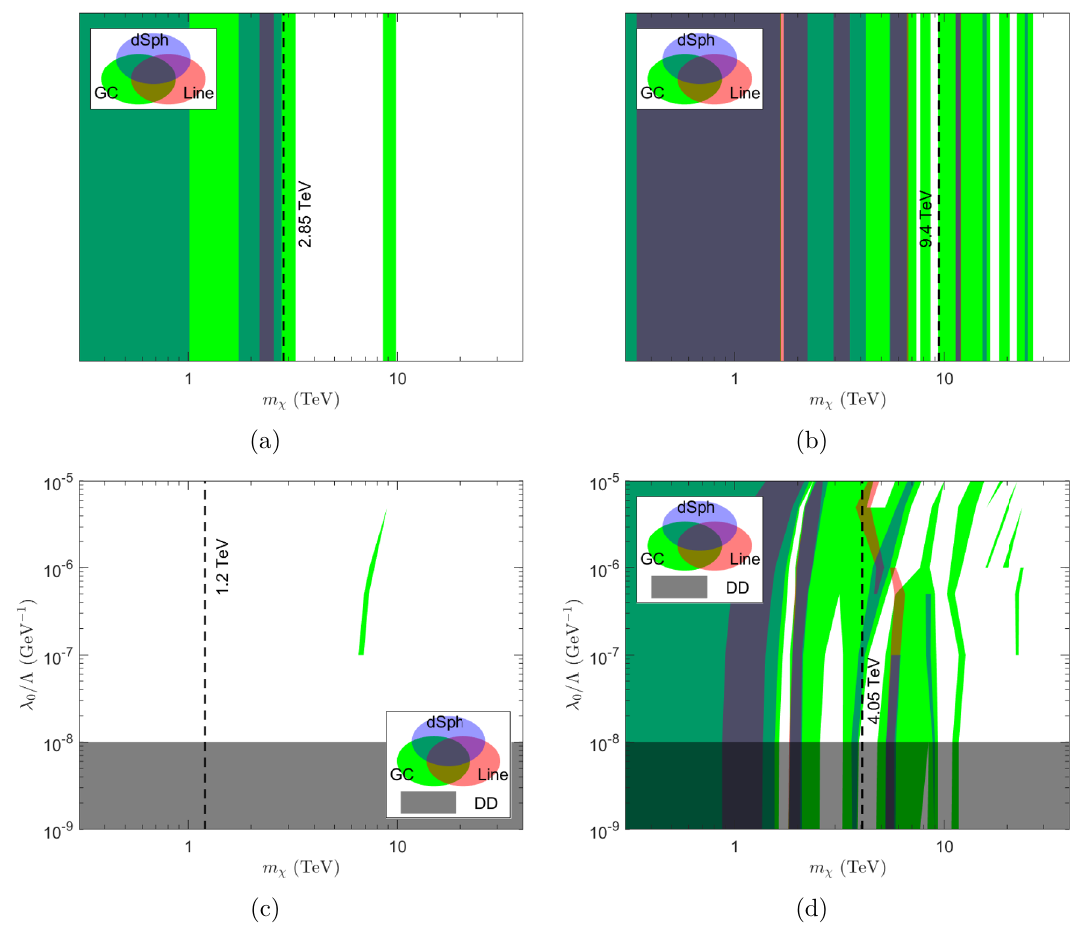
Figure 15. (Upper panels) Summary charts for the real triplet (left 15(a)) and quintet (right 15(b)) showing the allowed values of DM mass as the only free parameter. The vertical bars are ruled out by experimental constraints from the inner Galaxy (green), dwarf satellites (blue), and gamma-ray line searches (red). The vertical dash-line indicates the thermal mass which is fixed by the freeze-out mechanism. The vertical axis does not report any physical variable. It is provided for the real cases to make the comparison with complex models possible. (Lower panels) The mass-coupling m χ − λ 0 two-dimensional parameter space of the pseudo-real doublet (left 15(c)) and quartet (right 15(d)). Here, the horizontal grey region is excluded by direct DM